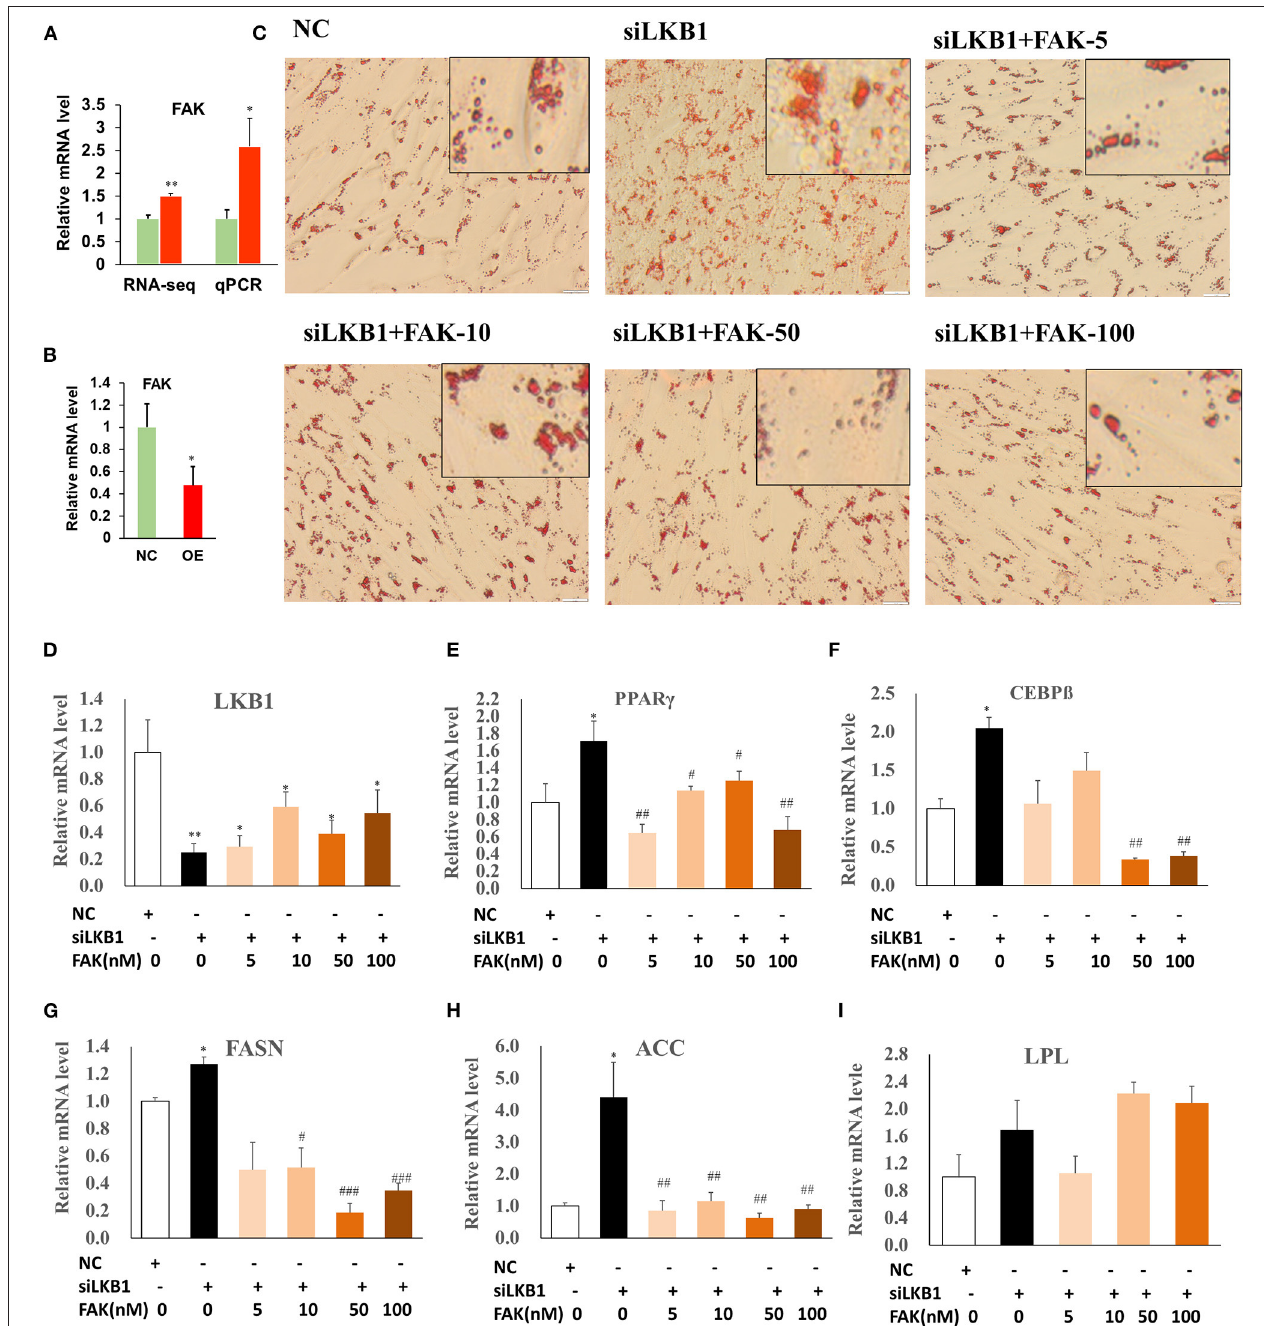
FIGURE 7 | Knockdown of LKB1 promotes intramuscular adipocyte lipid accumulation through FAK pathway. (A,B) The mRNA level of FAK gene in siRNA treatment (A) and LKB1 overexpressed (B) cells by qPCR analysis. (C) The oil red O staining images of intramuscular adipocyte cells in NC, siLKB1, and siLKB1 combined with different concentrations of FAK inhibitor (PF573228) treatment groups. (D–I) The mRNA level of LKB1 (D) , PPAR γ (E) , C/EBP β (F) , FASN (G) , ACC (H) , LPL (I) cells in NC, siLKB1, and siLKB1 combined with different concentrations of FAK inhibitor (PF573228) treatment intramuscular adipocyte cells. N = 6. * P < 0.05, ** P < 0.01, compared to those of NC group; # P < 0.05, ## P < 0.01, ### P < 0.001, compared to those of siLKB1 group. LKB1, liver kinase B1; FAK, focal adhesion kinase; NC, negative control. FASN, fatty acid synthase; ACC, acetyl-CoA carboxylase alpha; LPL, lipoprotein